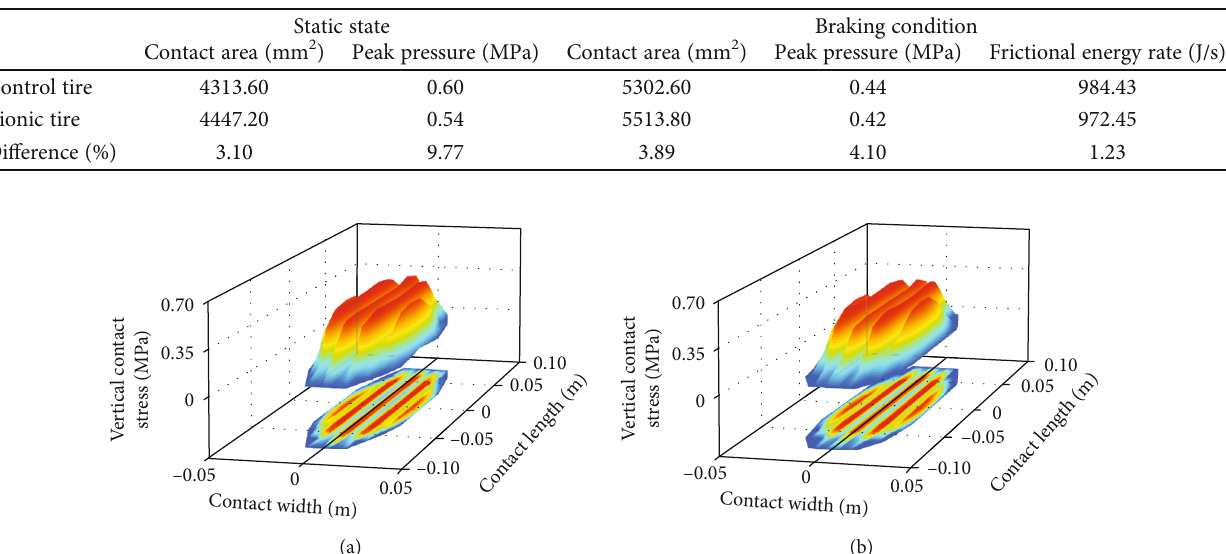
Figure 8: Contact patch and pressure distribution in the static state: (a) control tire; (b) bionic tire. Table 3: Comparison of the static state and braking condition.